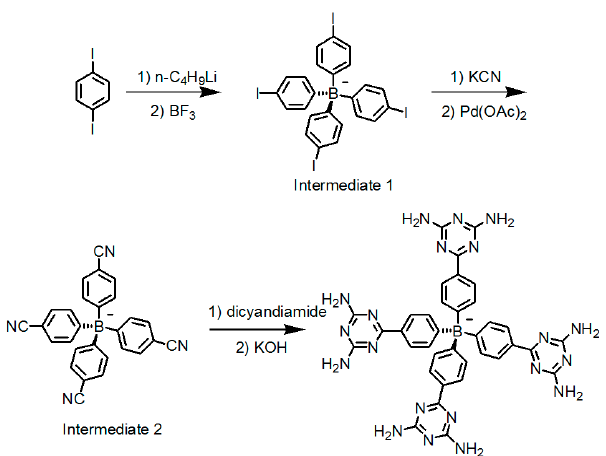
Figure 20. Synthesis route of negative charge tetrahedral building motif 23 .